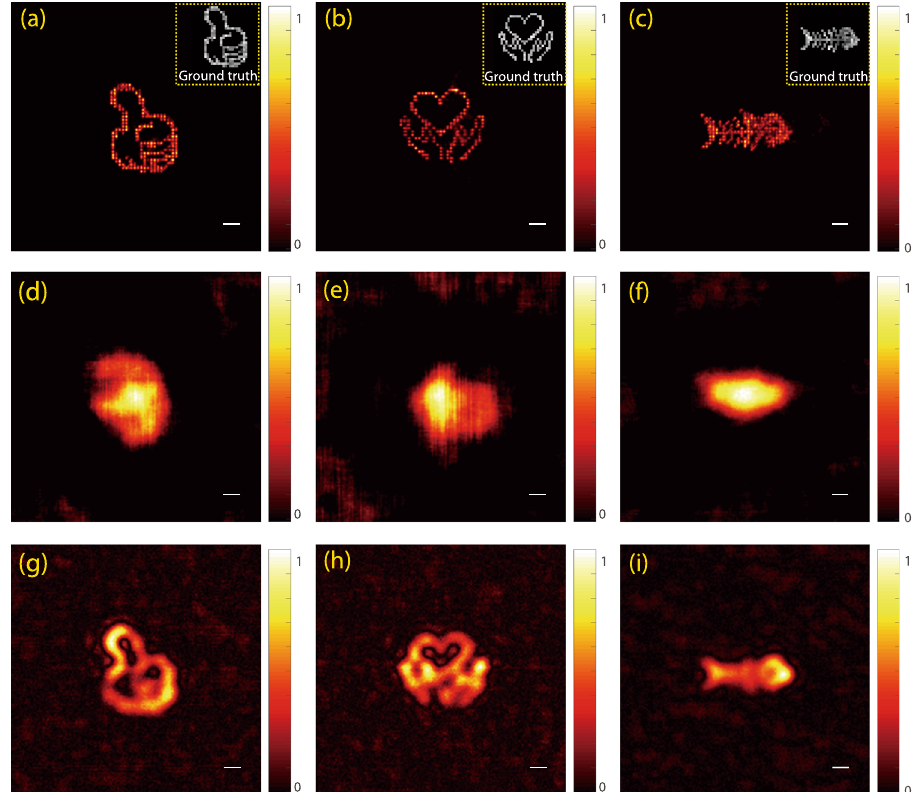
Fig. 4 Experimental demonstration of three techniques for imaging several complex objects hidden behind a ground glass diffuser. a – c Our SOSLI approach for non-invasive super-resolution imaging. Insets are ground truth objects. d – f Non-invasive imaging retrieved from autocorrelation of a single speckle pattern for the ground truth samples in the insets of a , b , c , respectively. g – i Invasive imaging by deconvolution approach with an invasively measured PSF for the ground truth samples in the insets of a , b , c , respectively. Scale bars: 6.5 µ